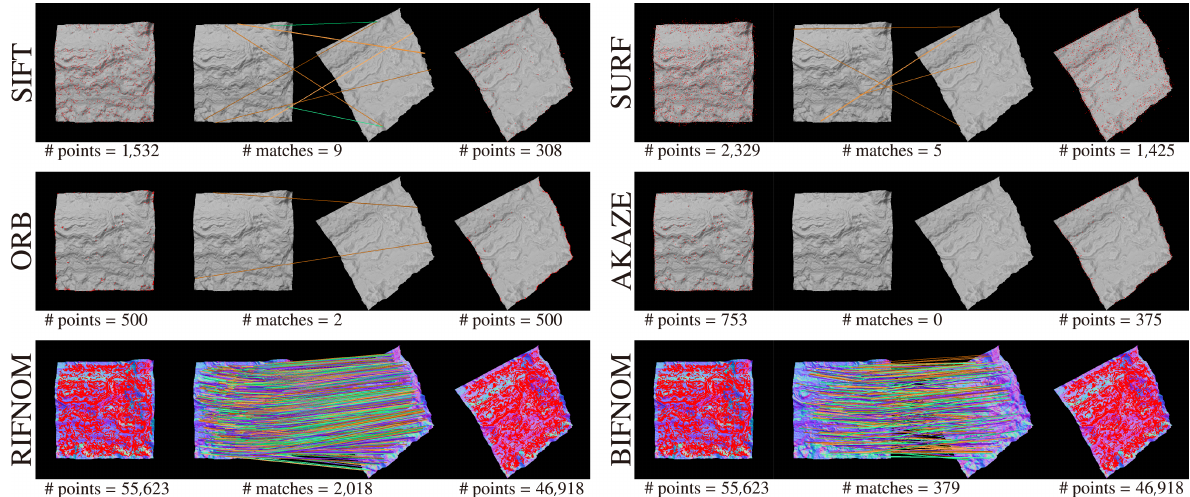
Figure 3. Interest point detection and matching for a textureless target. Detected interest points are shown in red. The symbol “#” means the number of interest points or